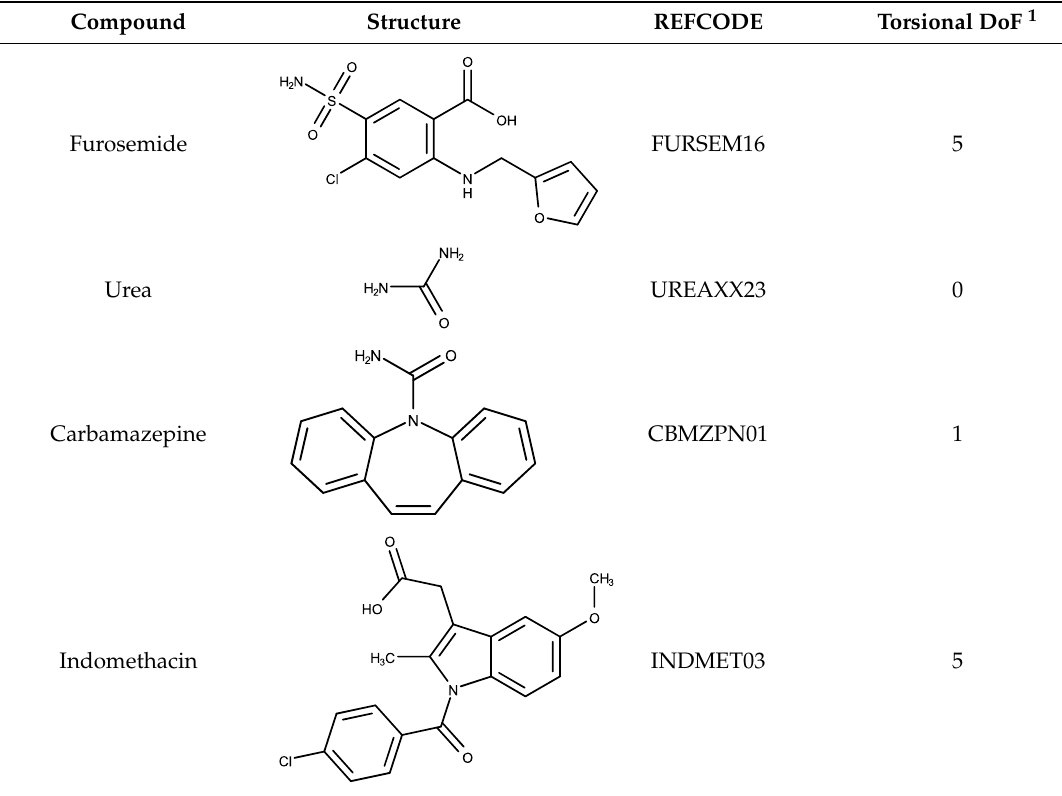
Table 2. Molecular structures and Cambridge Structural Database (CSD) REFCODEs for the materials used in this work.